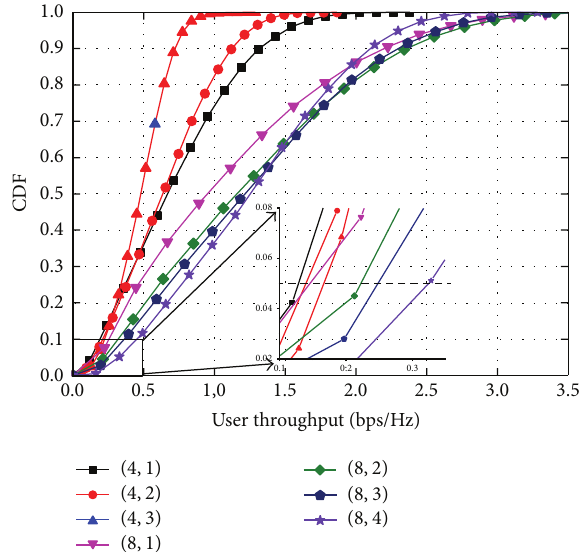
Figure 7: CDF of user throughput for DUSIA with different (𝑁,𝜉) . Cell edge SNR = 20